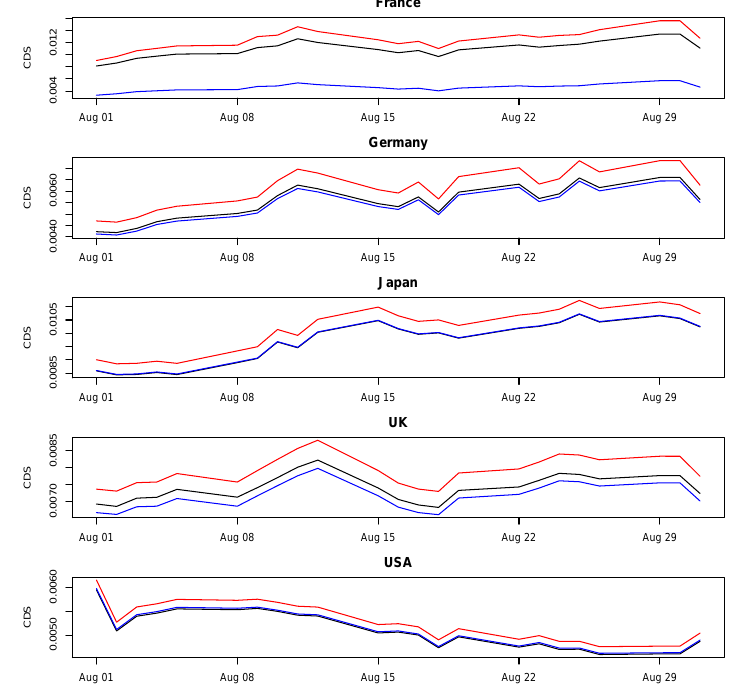
Figure 6. August 2011, predictive performance for core countries. For each considered core country, the graphs report the observed CDS spreads at time t (black line), the CDS spreads predicted at time t − 1 using the proposed model (red line) and the CDS spreads predicted at time t − 1 using only the autoregressive component (blue